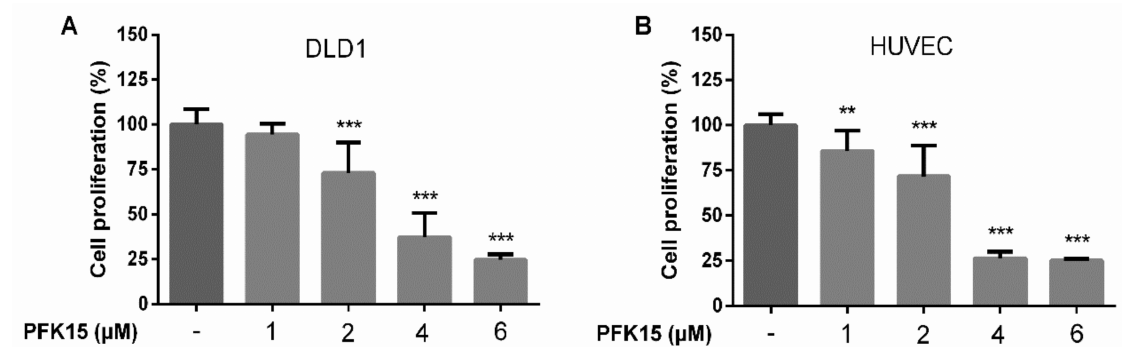
Figure 2. Proliferation of DLD1 ( A ) and HUVEC ( B ) cells was assessed after PFK15 treatment. Cell proliferation was determined based on bromodeoxyuridine incorporation into DNA. DLD1 and HUVEC cells were treated with PFK15 in a concentration range 1–6 µ M for 24 h. Alterations in cell proliferation were compared to the untreated control group. Data are presented as the mean ± SEM of three independent experiments. ** p < 0.01, *** p < 0.001 significant difference compared to untreated control